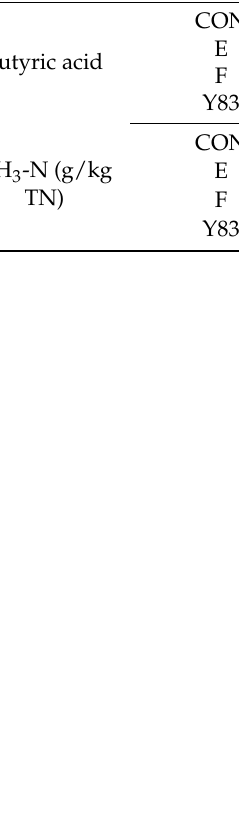
Table 3. Effect of additives on structural carbohydrate compositions of rice straw silage (g/kg